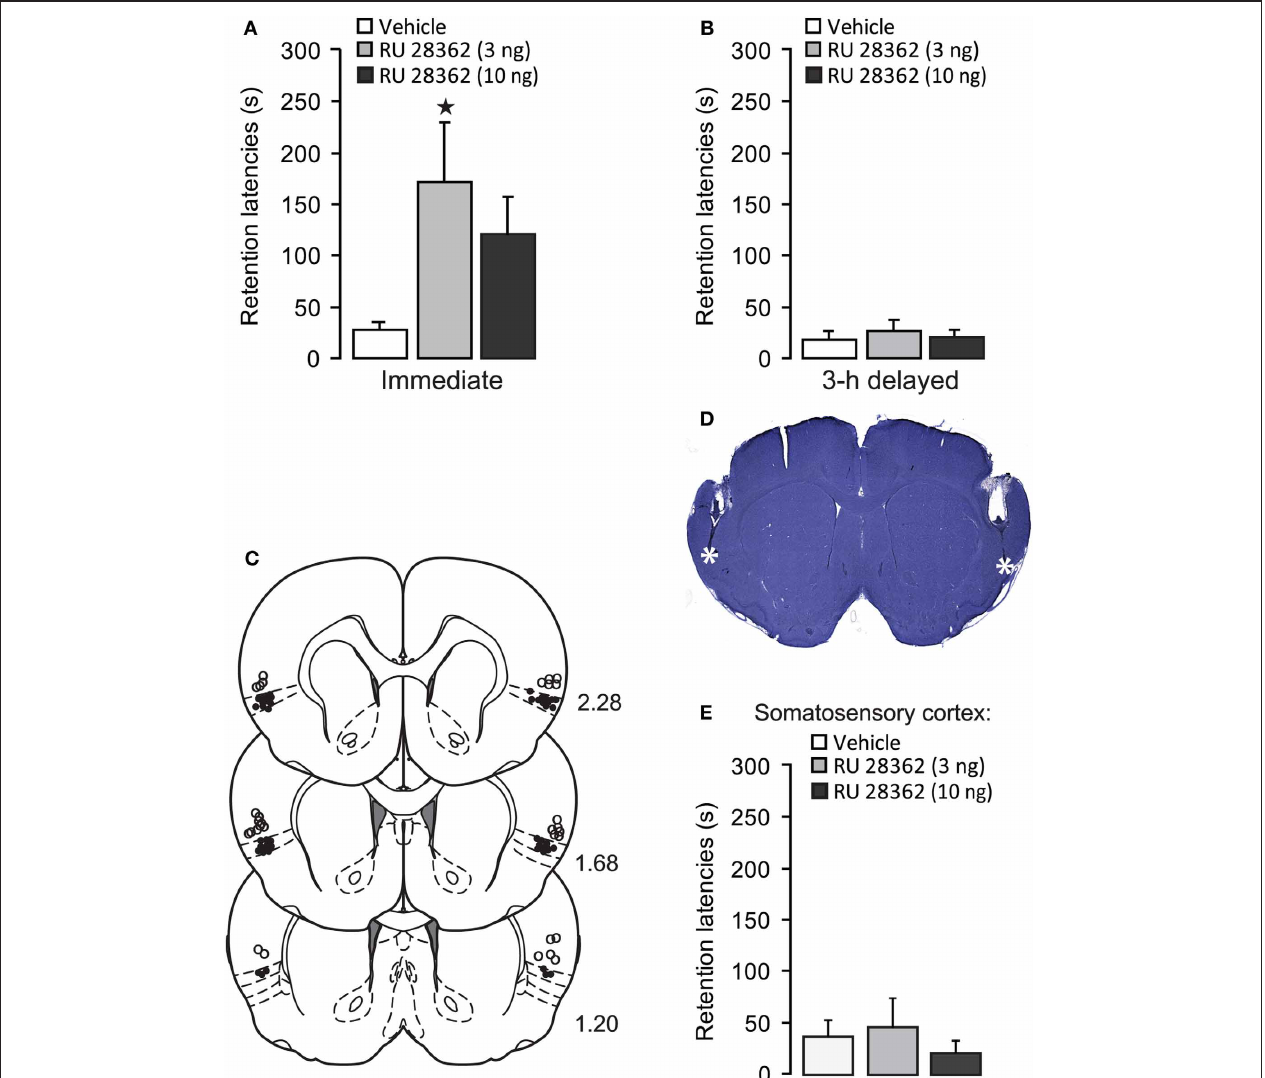
FIGURE 1 | Glucocorticoid receptor agonist administration into the insular cortex enhances memory consolidation of inhibitory avoidance training. (A) Step-through latencies (mean ± SEM) in seconds on the 48h inhibitory avoidance retention test of rats given bilateral infusions of the glucocorticoid receptor agonist RU 28362 (3 or 10ng in 0.5 μ l) into the IC immediately after training. ∗ p < 0 . 05 as compared with the vehicle-treated group ( n = 11–12 per group). (B) Step-through latencies (mean ± SEM) in seconds on the 48h inhibitory avoidance retention test of rats given the glucocorticoid receptor agonist RU 28362 (3 or 10ng in 0.5 μ l) into the IC 3h after training ( n = 6–7 per group). (C) Location of injection